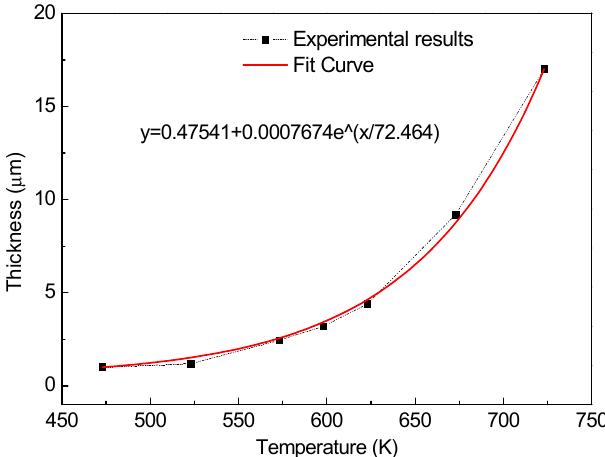
Figure 6. Variation of the thickness of intermetallics layer as a function of annealing temperature.